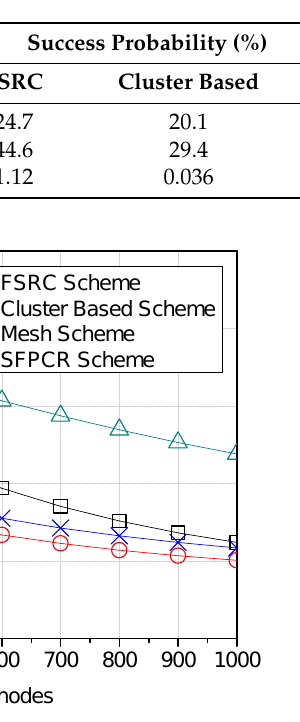
Table 3. Simulation results.